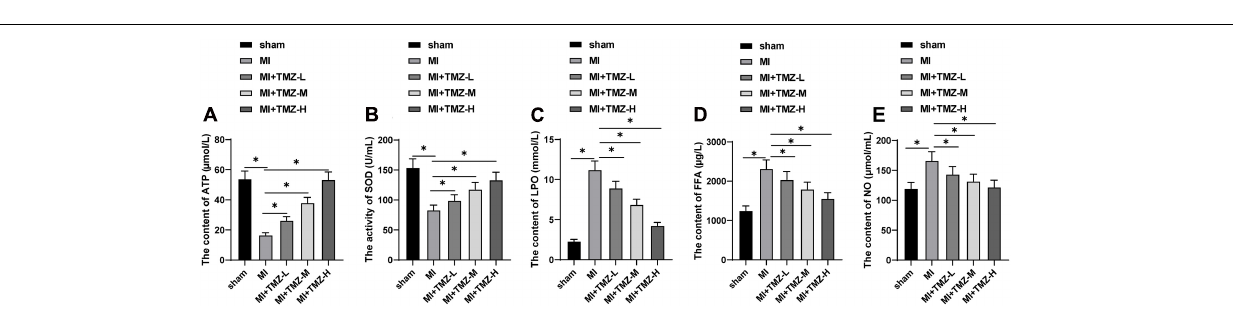
Frontiers in Physiology |